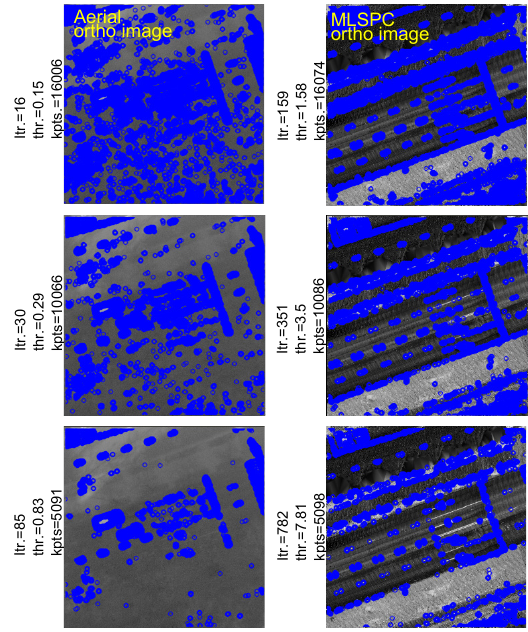
Figure 7. Adaptive Harris keypoint detection of a whole tile, with the total number of keypoints, threshold and required iterations.